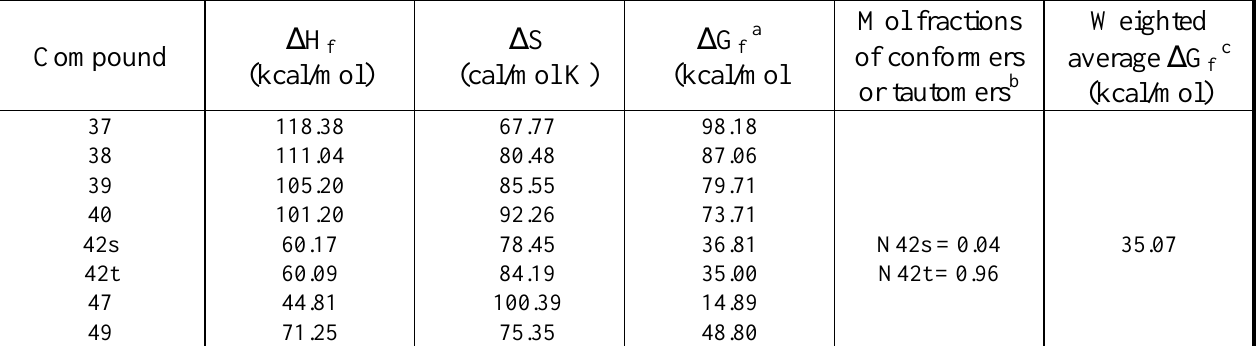
Table 2. The AM1 calculated thermodynamic properties of protonated pyridine derivatives in aqueous solution ( e